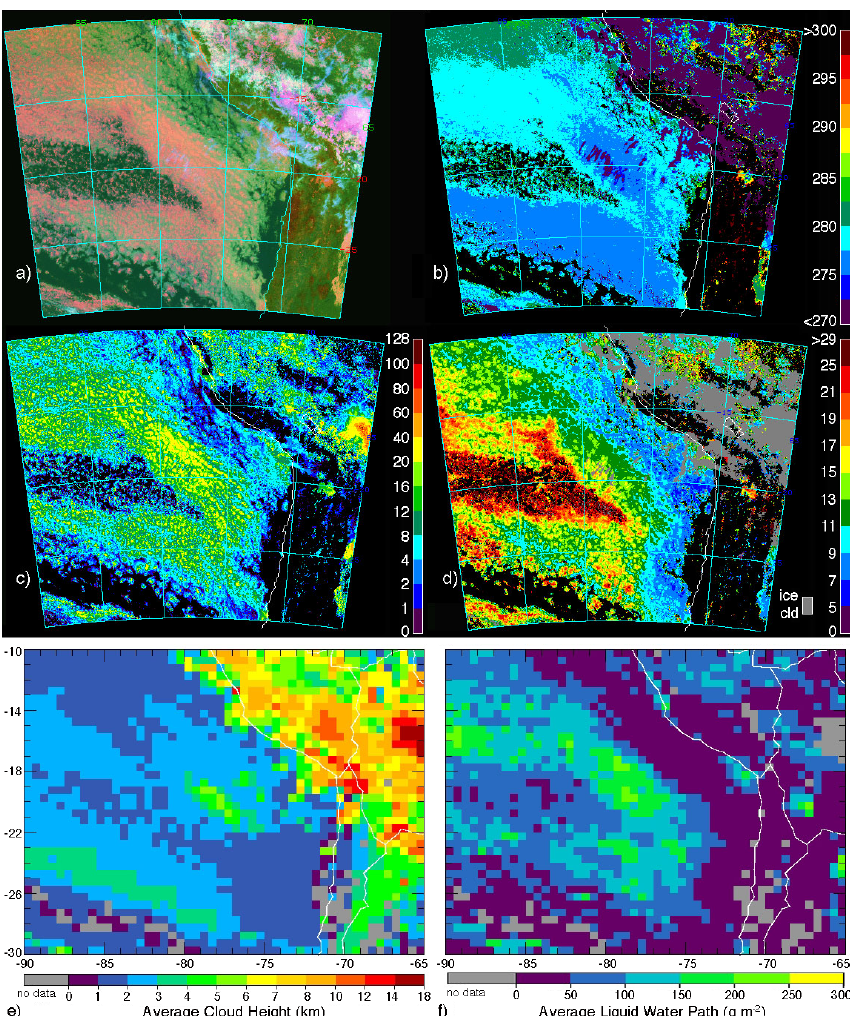
Fig. 10. GOES-10 imagery and retrieved cloud parameters, 15:45 UTC, 27 October 2008: (a) pseudocolor RGB image; (b) cloud effective temperature [K]; (c) cloud optical depth; (d) cloud liquid water droplet effective radius [µm]. Regional (0.5 × 0.5 ◦ ) average cloud properties, (e) cloud top height, and (f) cloud liquid water path for the same